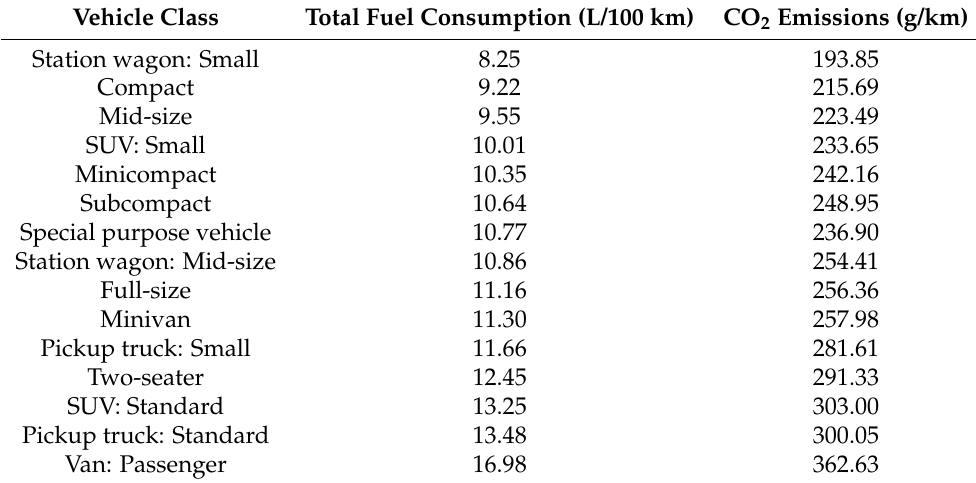
Table 4. CO 2 emissions (g/km) and total fuel consumption (L/100 km) of each vehicle class.